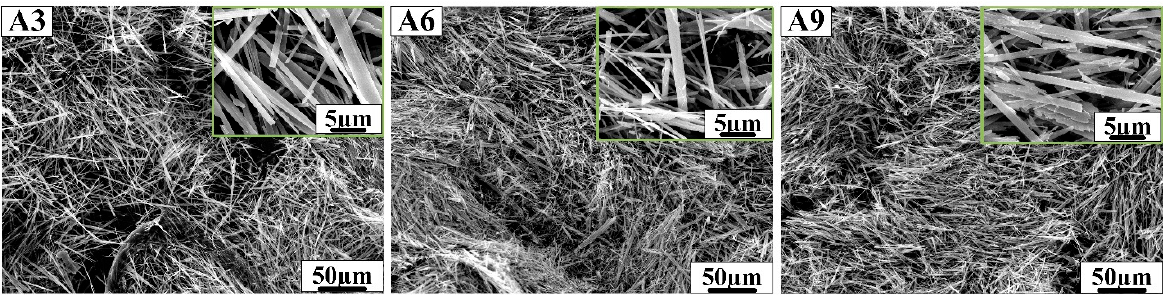
Figure 4. SEM morphology of samples A3, A6 and A9 prepared in sulfuric acid solution.